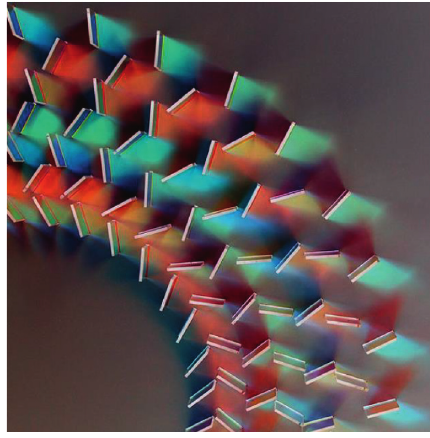
Figure 2: Schematic diagram of